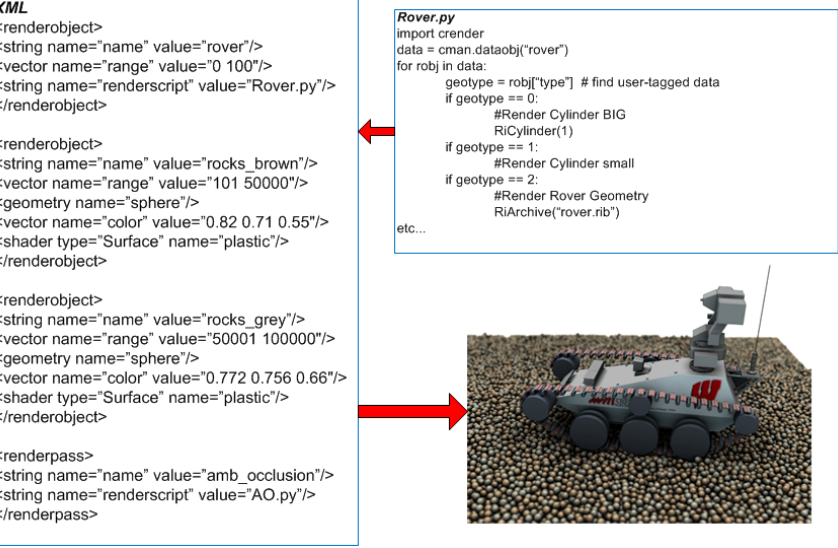
Figure 25. General purpose rendering with Chrono ::Render. The Rover body contains multiple shape descriptions of which are generated from a Python script. Data is tagged with a name which can be later be accessed using some of Chrono ::Render’s Python func- tionality.